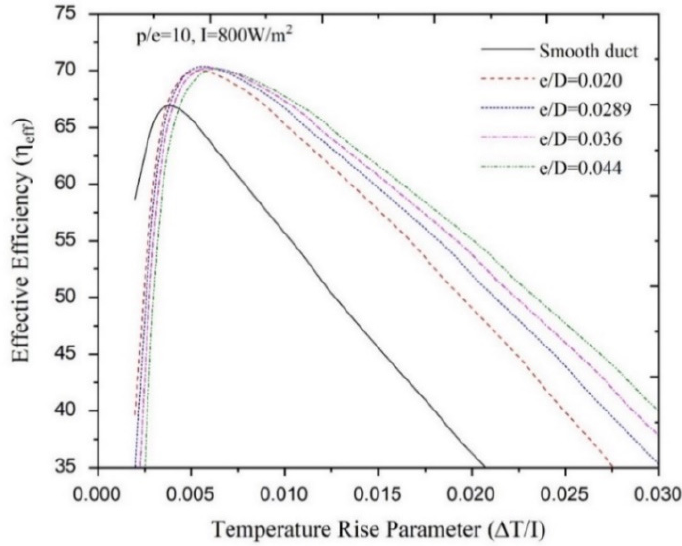
Figure 6. Effect of temperature increase parameter on effective efficiency. Table 2. Ranges of temperature increase parameters and Reynolds